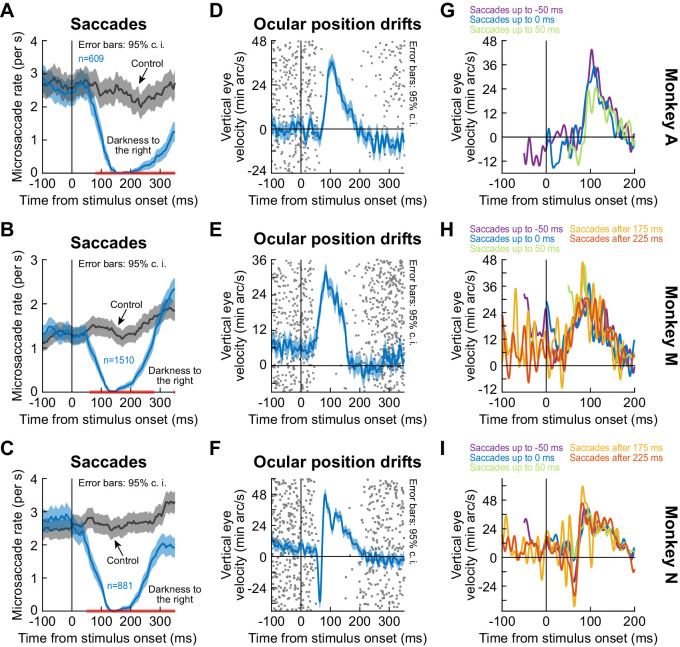
The drift response starts when saccades are inhibited.(A–C) Our monkeys exhibited known saccadic inhibition (Buonocore et al., 2017a; Buonocore and McIntosh, 2008; Edelman and Xu, 2009; Hafed and Ignashchenkova, 2013; Hafed et al., 2011; Reingold and Stampe, 2002) after stimulus onset (split view condition shown; Figure 4—figure supplement 1 shows the fixation flash condition). Error bars denote 95% confidence intervals. (D–F) In the same sessions, saccade-free fixation epochs (no saccades from −100 to 350 ms) showed the ocular position drift response (error bars denote 95% confidence intervals). The timing of this drift response was linked to the timing of saccadic inhibition (individual dots show individual trial rasters of microsaccade onset times from A–C). The drift response started when microsaccades were inhibited. (G–I) When we combined (A–C) and (D–F), we found that even when microsaccades occurred near the time of drift response (i.e. before or after with shorter saccade-free epochs than in D–F), the drift response could still occur. In (G), two curves are missing because they had <10 trials due to the prolonged saccadic inhibition profile in (A). The different colors show traces in which there were microsaccades within a given time range relative to stimulus onset. For example, ‘Saccades up to −50 ms’ means that the curve shows average smooth eye velocity from −50 ms onwards, since earlier times had saccadic velocities in them. Similarly, the curve for ‘Saccades after 175 ms’ would mean that average eye velocity is shown up to 175 ms, since later times relative to stimulus onset had saccadic velocities in them. Error bars in (D–F) denote 95% confidence intervals. Also see Figure 4—figure supplement 1 and Figure 2—figure supplements 3 and 4.
Figure 4—source data 1.Excel table with the source data for this figure.